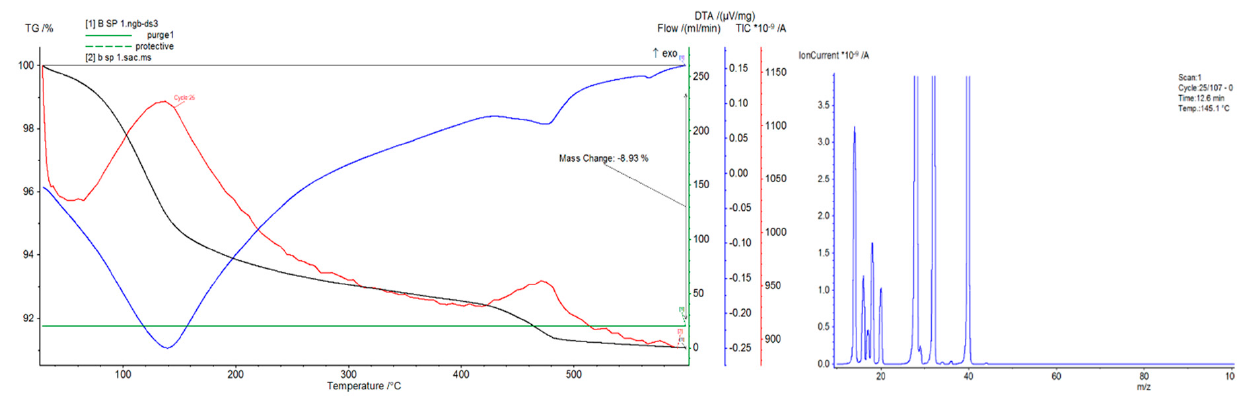
Figure 7. Thermal analysis DTA/DSC of sample 3.